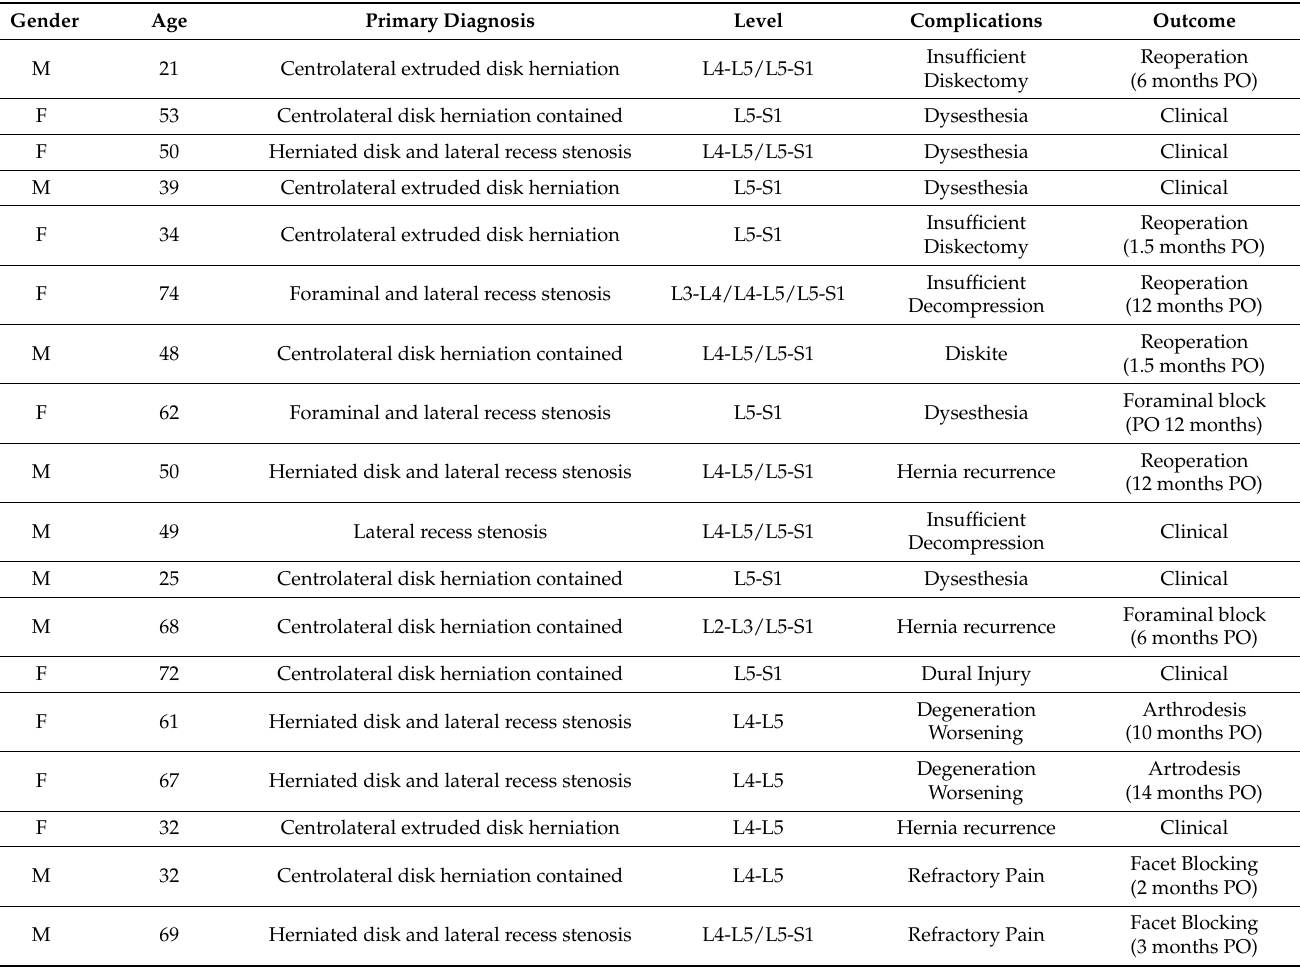
Table 5. Description of complicated cases according to gender (M = male/F = female), age (years), primary diagnosis, surgical level, type of complication, and